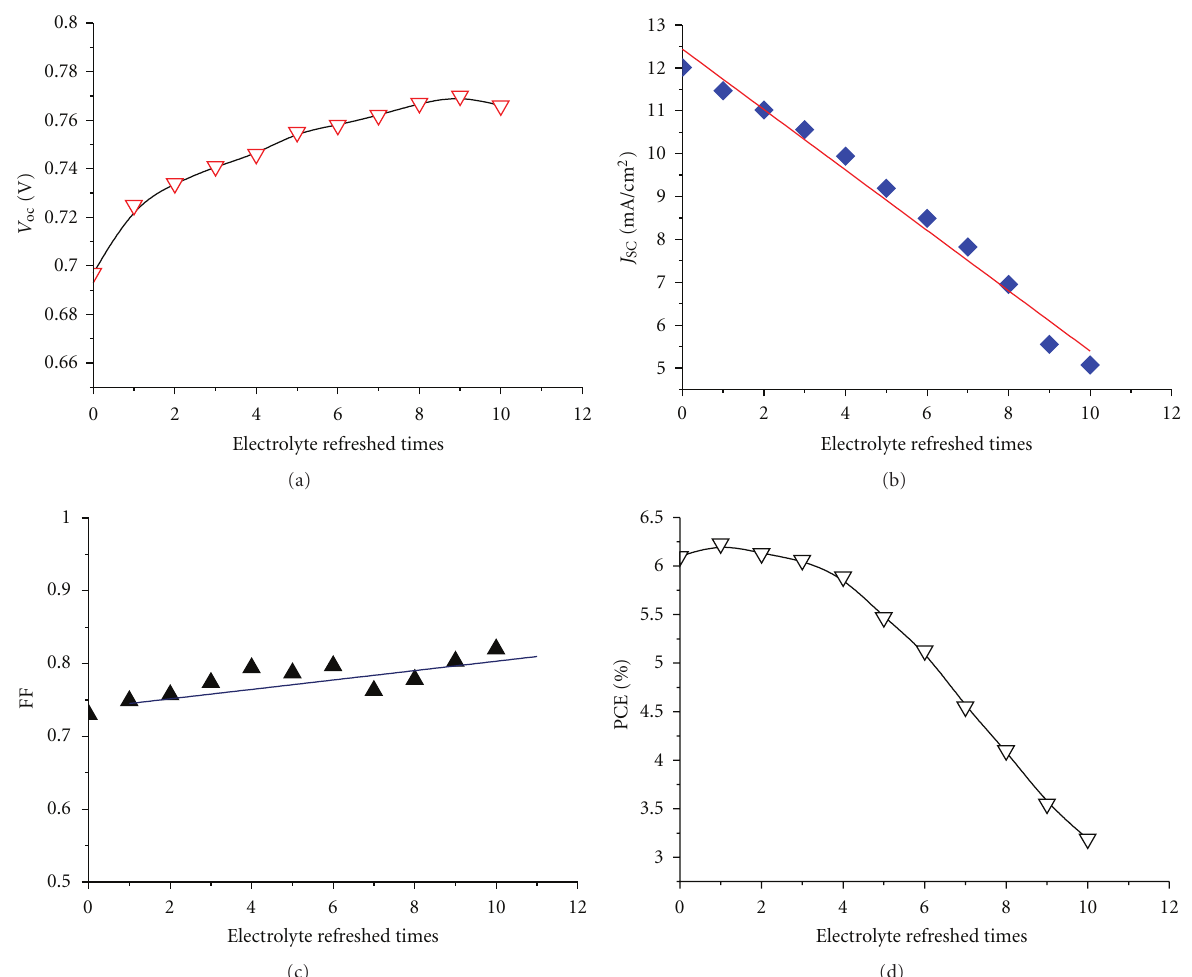
Figure 3: Dependency of V oc (a), J sc (b), FF (c), and PCE (d) on electrolyte refreshing